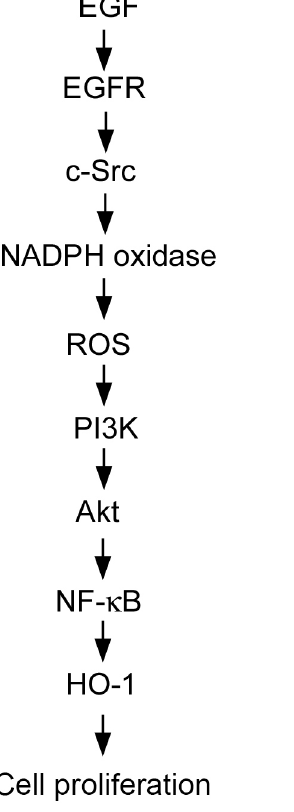
Figure 10. Schematic summary indicating how signal trans- duction by epidermal growth factor (EGF) induces HO-1 expression in human HT-29 colon cancer cells. EGF activates the c-Src, NADPH oxidase, and PI3K/Akt pathways, which in turn induces NF- k B activation and HO-1 expression in human colon cancer cells. Moreover, HO-1 is involved in EGF-induced colon cancer